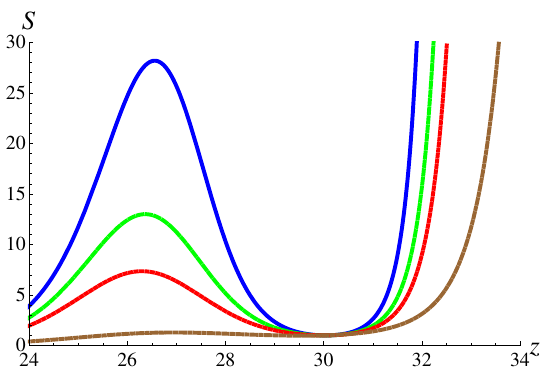
Figure 2 . The plot of S (normalized by S ( n )) for the same values of b as (cid:12)gure 1 in the case a = n = 30, m 0 = 1, q 0 = 3, and B 0 = 0 : 98.